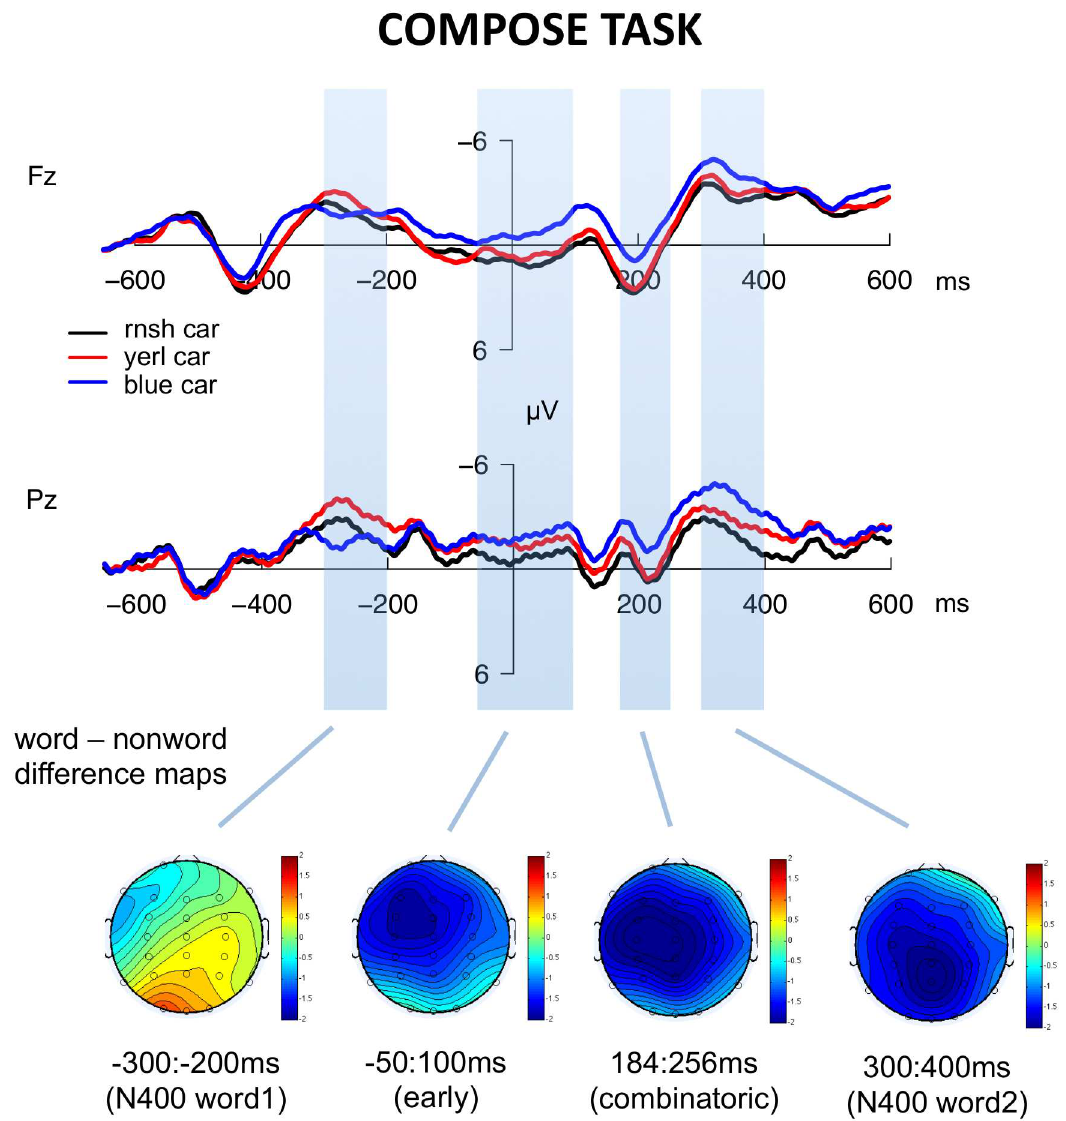
Fig 3. ERP waveforms and topographical distributions for the three conditions in the compose task. Waveforms illustrate the responsesat representative electrodes Fz and Pz. Scalp maps illustrate the estimated activity resulting from the subtraction real word—nonword ( blue car — rnsh car ) averagedacross the time-window indicated.